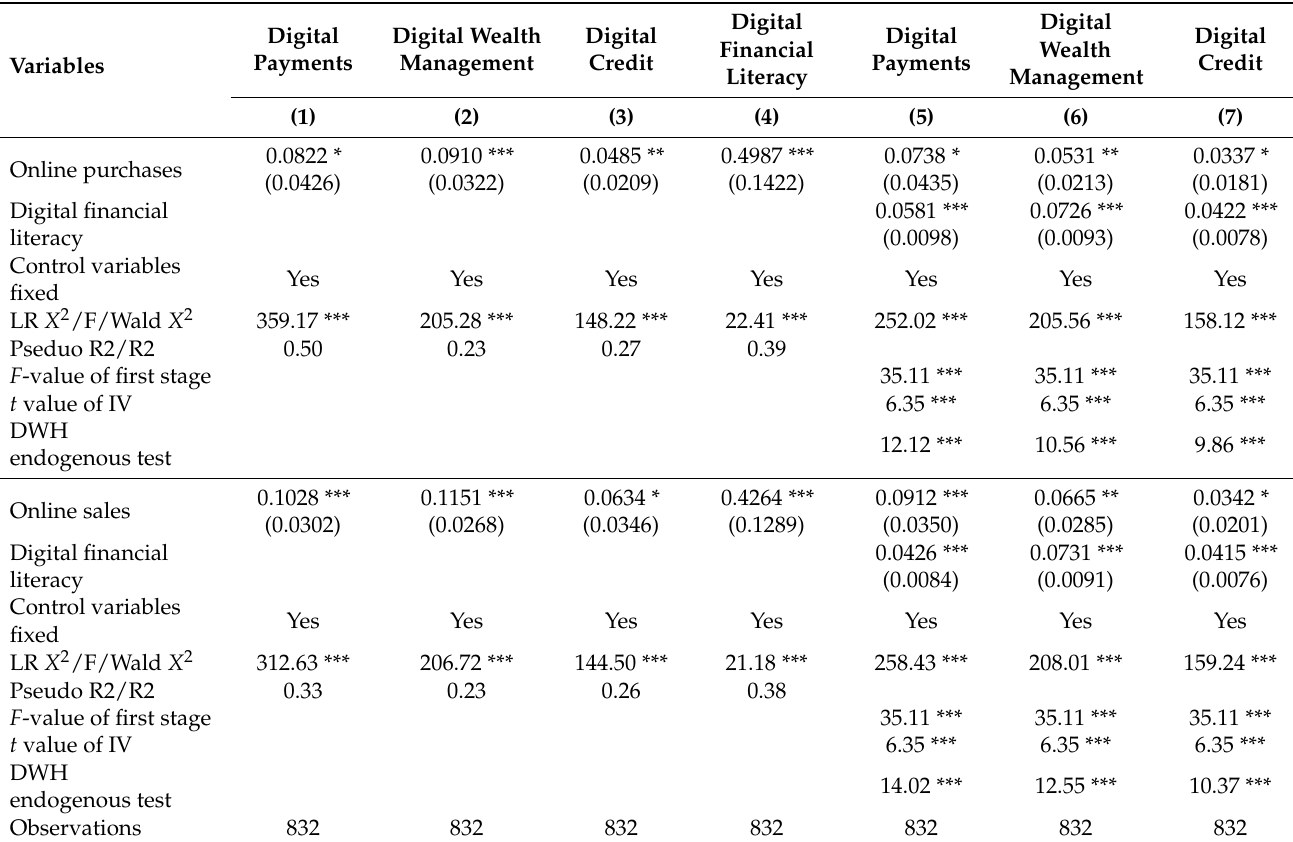
Table 4. The mediation effect of digital financial